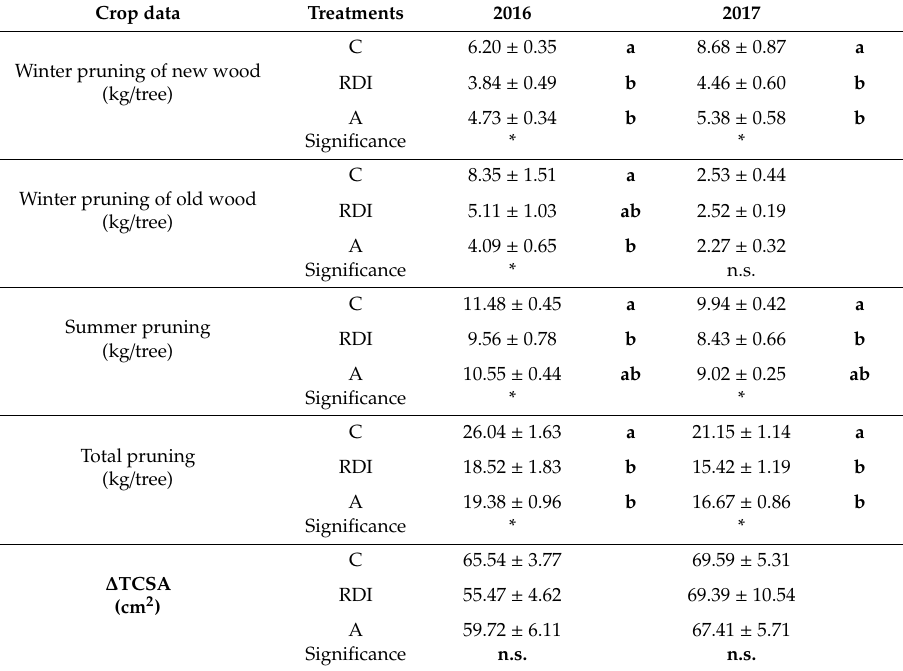
Table 3. E ff ects of irrigation on annual winter pruning of new wood, winter pruning of old wood, the